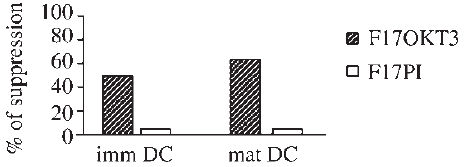
FIGURE 1 Anergic T cells inhibit T cell proliferation induced by “mature” and “immature” DC. Responder F17 (5 £ 10 3 ) was cultured for 72h with 5 £ 10 3 DRB1*1101 þ “mature” or “immature” DC pulsed with HA307-19 in the absence or in the presence of 1.5 £ 10 4 either anergic (F17OKT3) or PI-activated F17 (F17PI). The results obtained in a proliferation assay, are expressed as percent of inhibition of responder F17 proliferation and derived by one representative experiment.